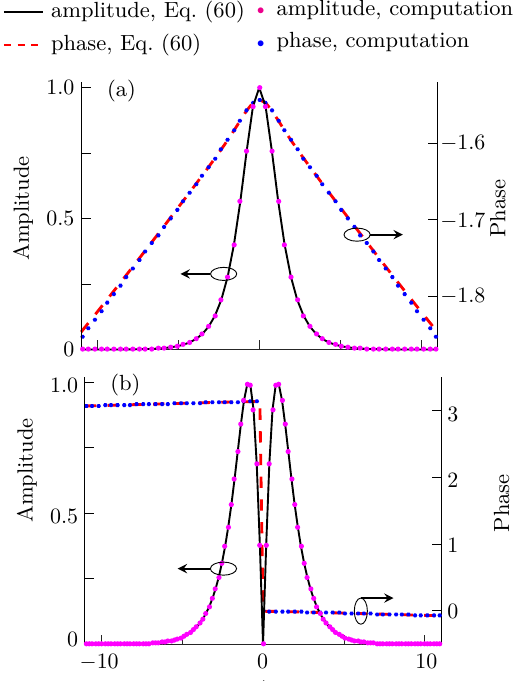
Fig. 1. The eigenmodes due to (a) the amplitude and (b) the Figure 1: The eigenmodes due to (a) the amplitude and (b) the cen- central frequency perturbation. tral frequency